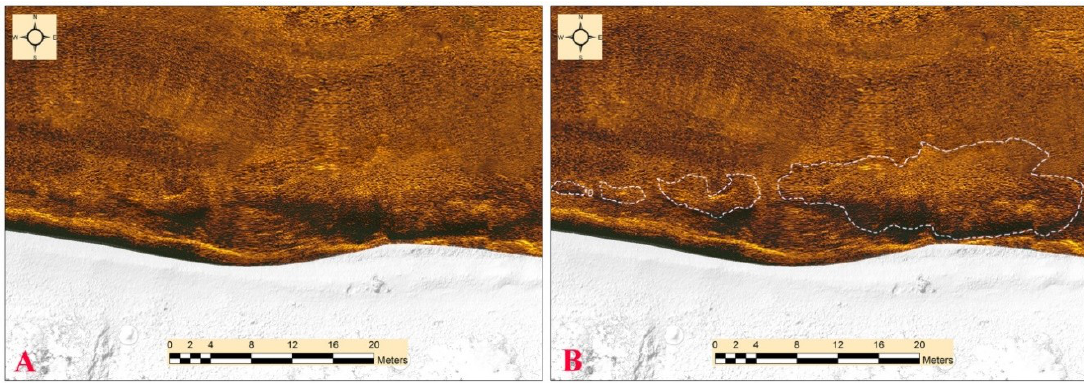
Figure 6. Example data from the Lowrance Elite-7 Ti and indicative processing steps in ReefMaster software. ( A ): part of the USV survey lines with colormap indicating bathymetry, ( B ): unprocessed bathymetric profile (upper half) and raw side scan sonar (SSS) sonograph (bottom half) as acquired through Lowrance Elite-7 Ti, ( C ): rough bathymetric map of the area of beachrocks and ( D ): an example of mosaicked SSS data (incomplete